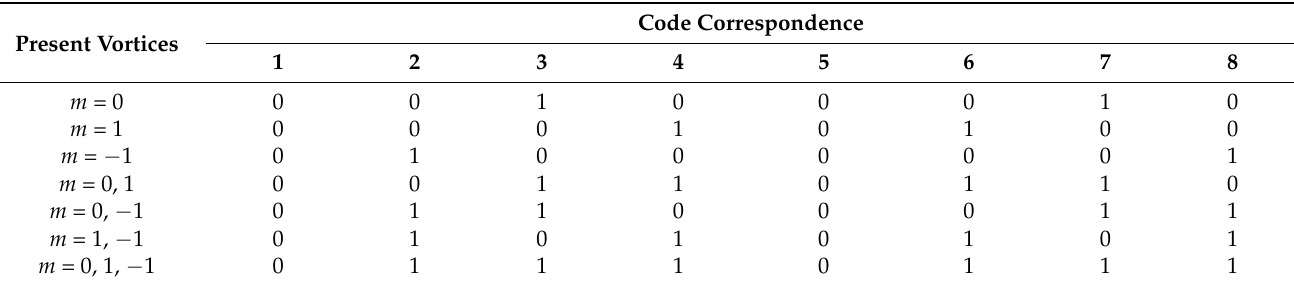
Table 3. Code correspondence of diffraction order numbers to the presence of phase vortices in the analyzed beam for a cylindrical state of the second order polarization ( p =